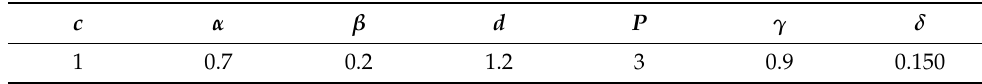
Table 5. The basic